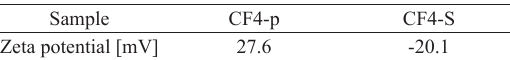
Table 1. Zeta potential (measured at pH=6.5) of PDDA functionalized silica core/ferrite shell particles (sample CF4-p) and silica core/ferrite shell particles with deposited external silica layer (sample CF4-S).